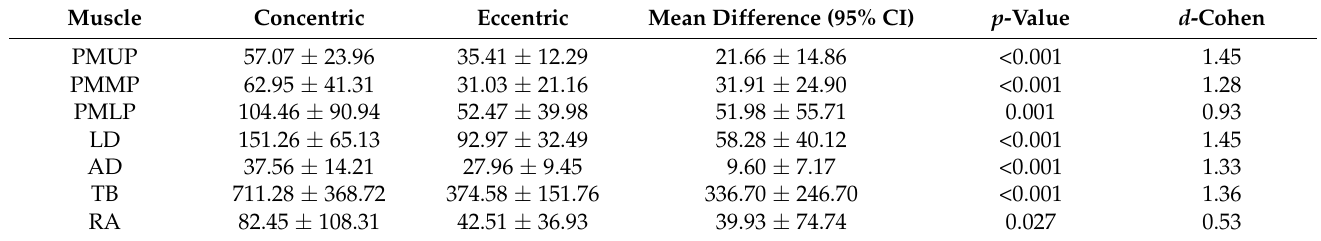
Table 3. Comparison of EMG activity (expressed in µV) during the concentric and eccentric phases in the straight arm pulldown exercise at 100% biacromial width. Mean ± standard deviation (SD).